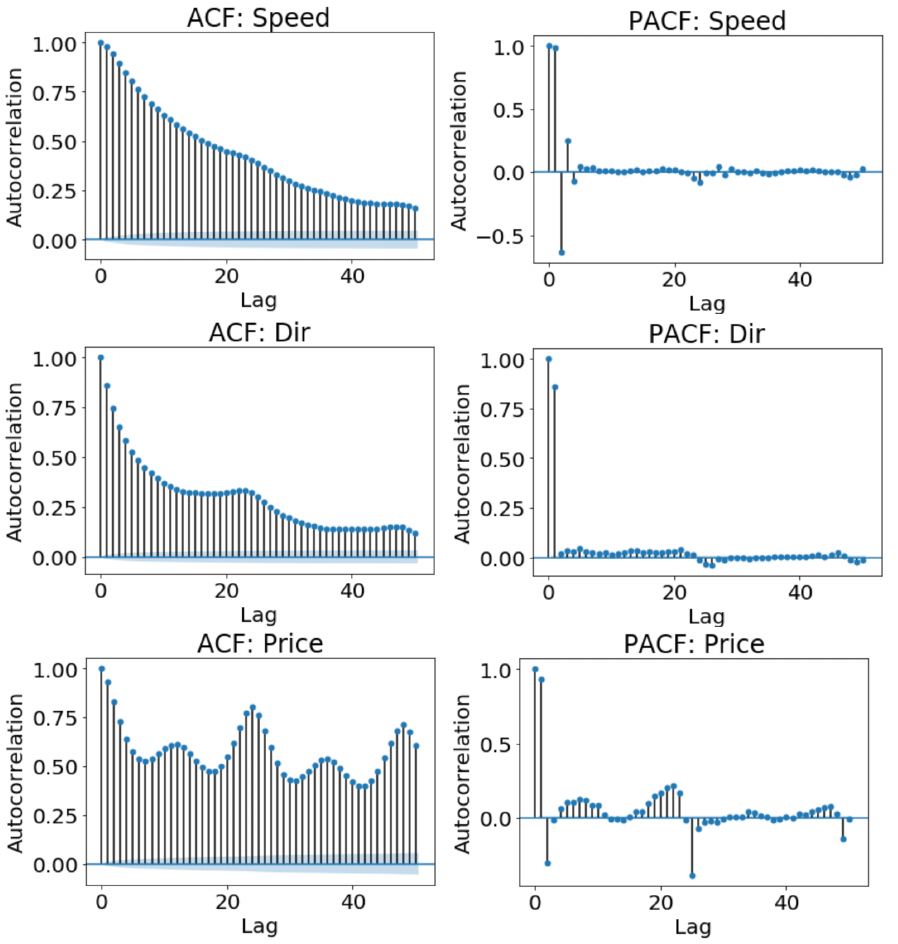
Figure 7. Autocorrelation ( left ) and partial autocorrelation ( right ) function for up to 50 lags of wind speed ( top ), wind direction ( middle ) and price ( bottom